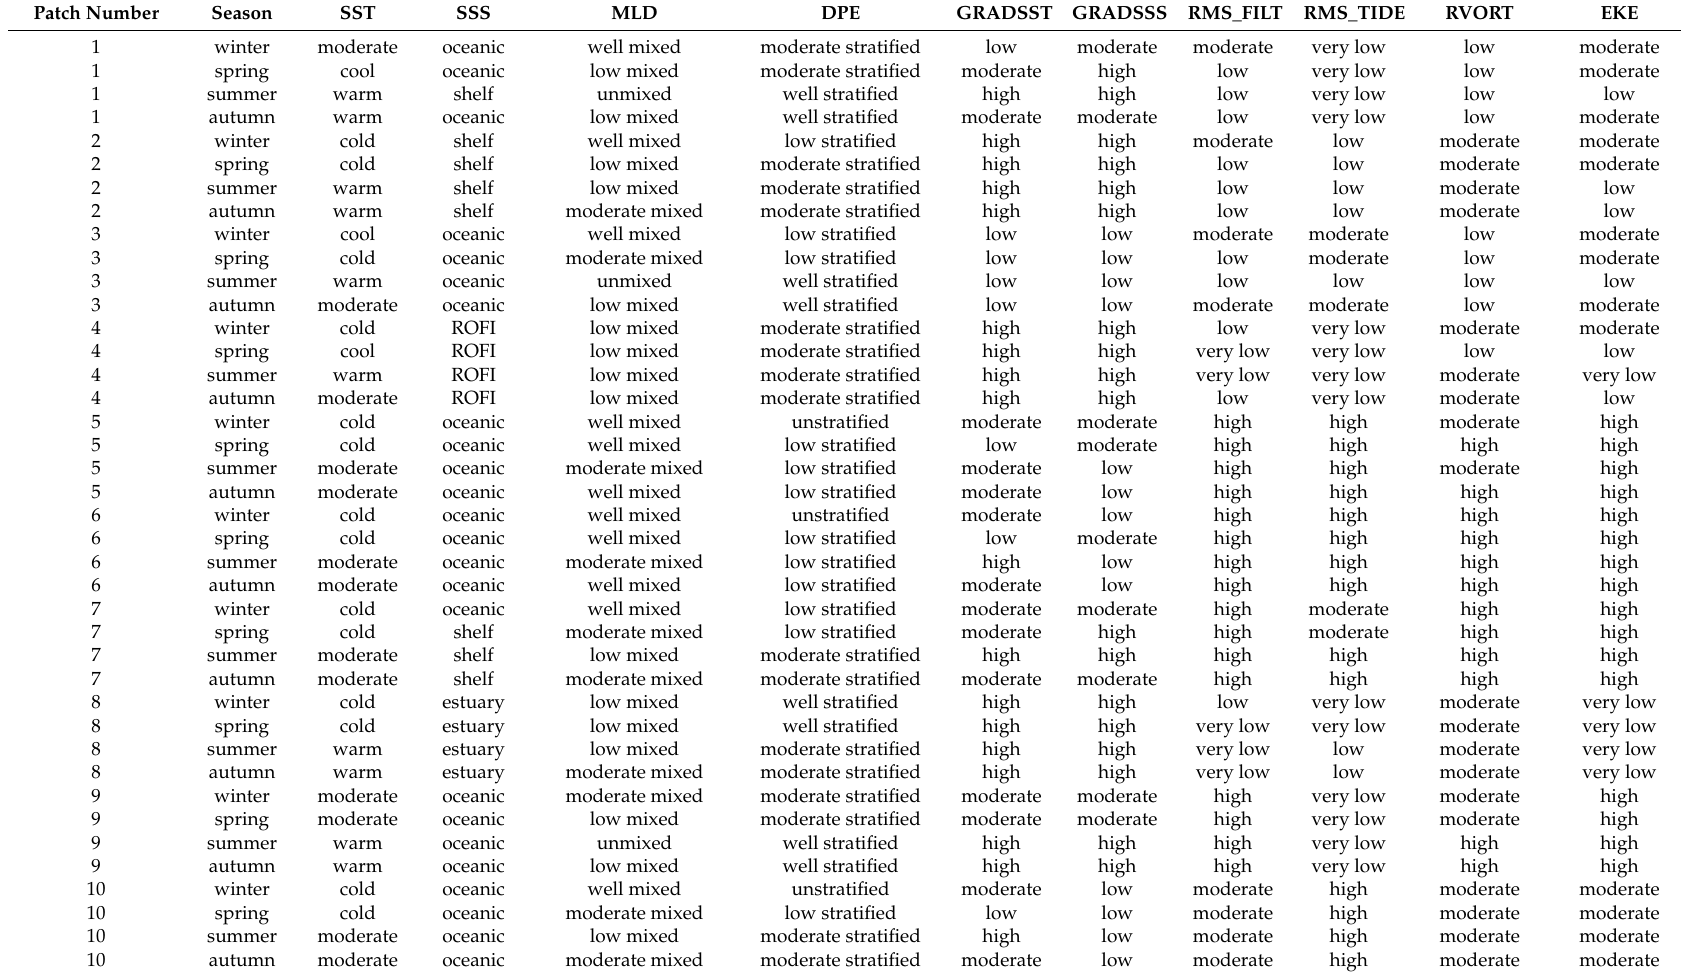
Table 4. Seasonal hydrographical typology of the 10 patch classes. Links between typology and the 25th, 50th, 75th range of variability of EOVs distribution are shown in Table